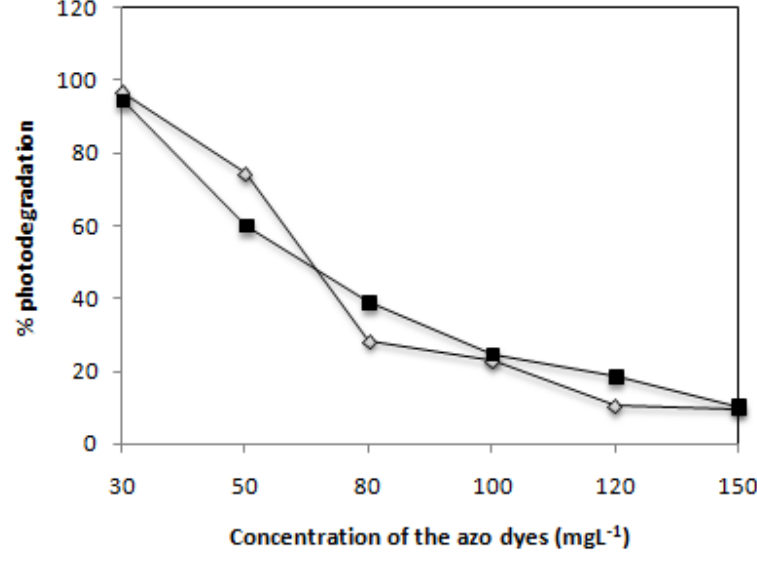
Figure 8. Effect of the initial concentration of C.I. Reactive Red 239 ( ) and C.I Reactive Black 5 ( ) dyes on the efficiency attained after 2 h of irradiation with 0.1 g·L − 1 of TiO and 2,60 mW/cm 2 of irradiation power by a 125 W mercury 2